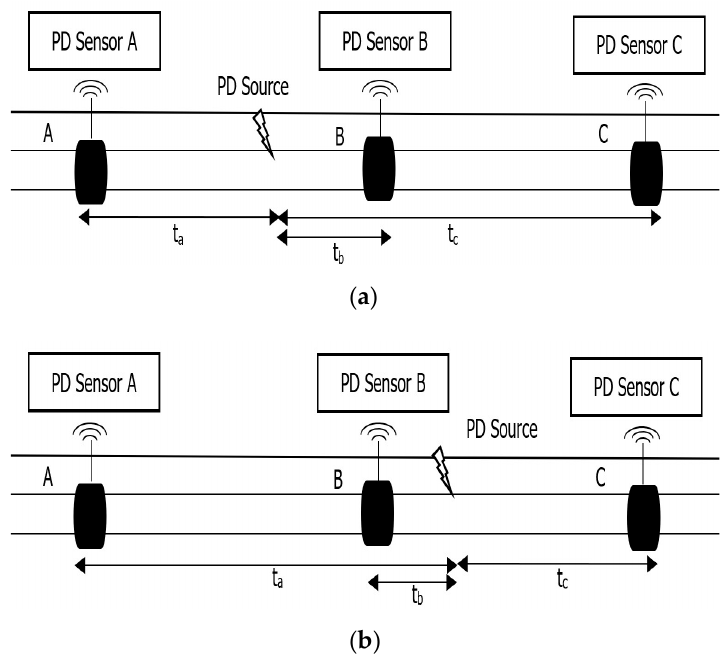
Figure 1. ( a ) PD occurs between A and B. ( b ) PD occurs between B and C.